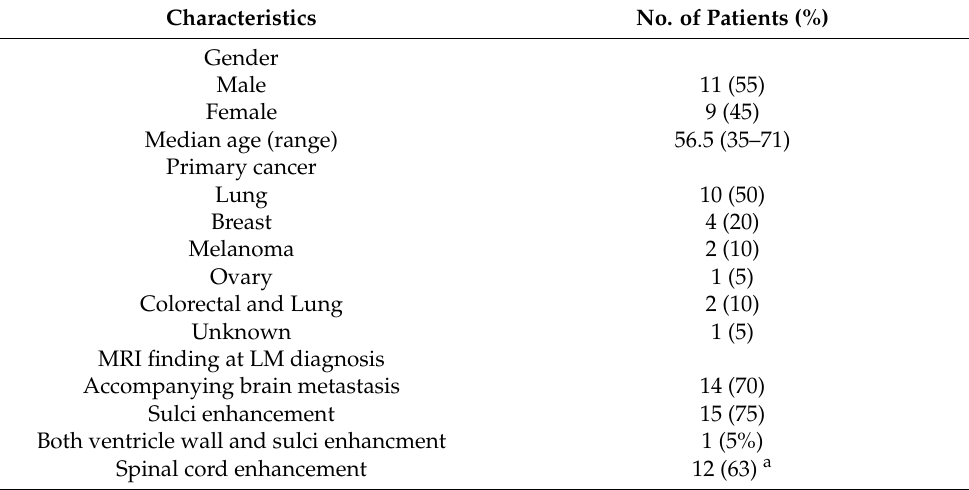
Table 1. Clinical characteristics of patients ( n =